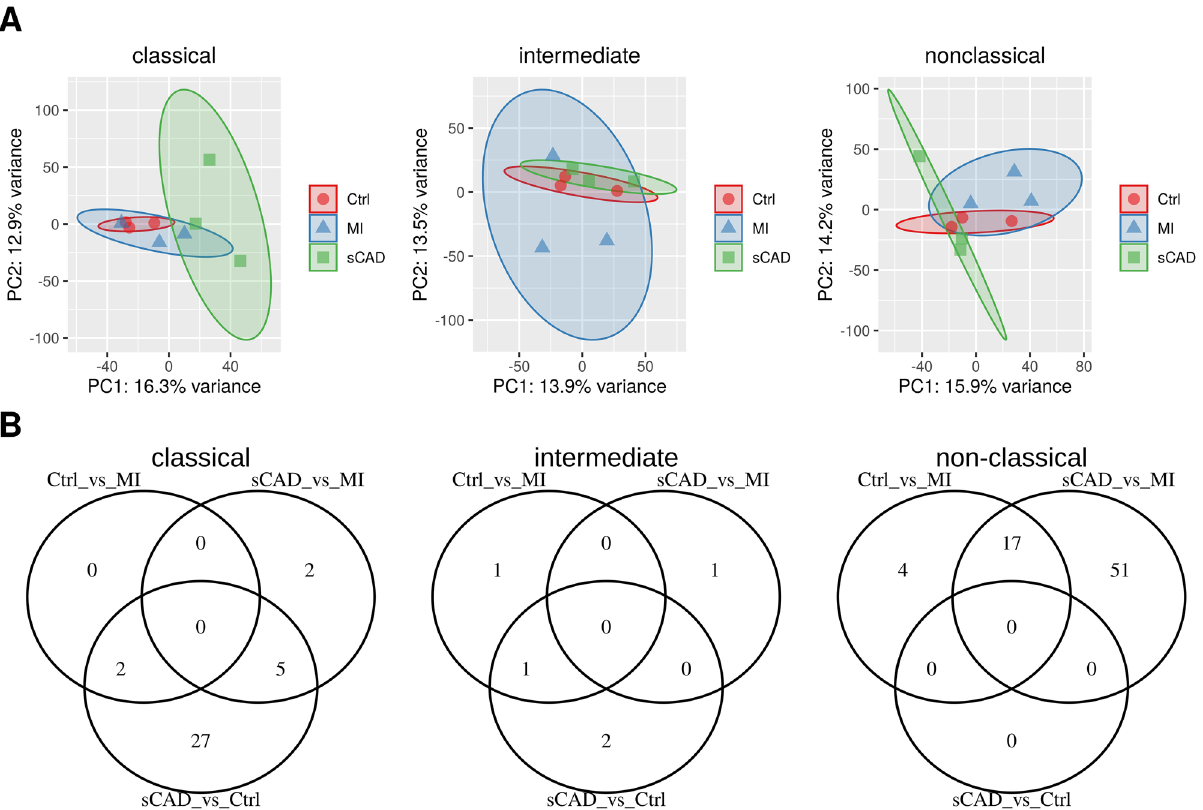
Figure 4. ( A ) Principal component analysis (PCA) plot of the different monocyte subsets for the investigated control samples (Ctrl) and the two diseased phenotypes, patients suffering from an acute myocardial infarction (MI) and stable coronary artery disease (sCAD) based on miRNA expression. ( B ) The majority of differentially expressed miRNAs between phenotypes highlights the importance of the classical monocytes for CAD and nonclassical monocytes for